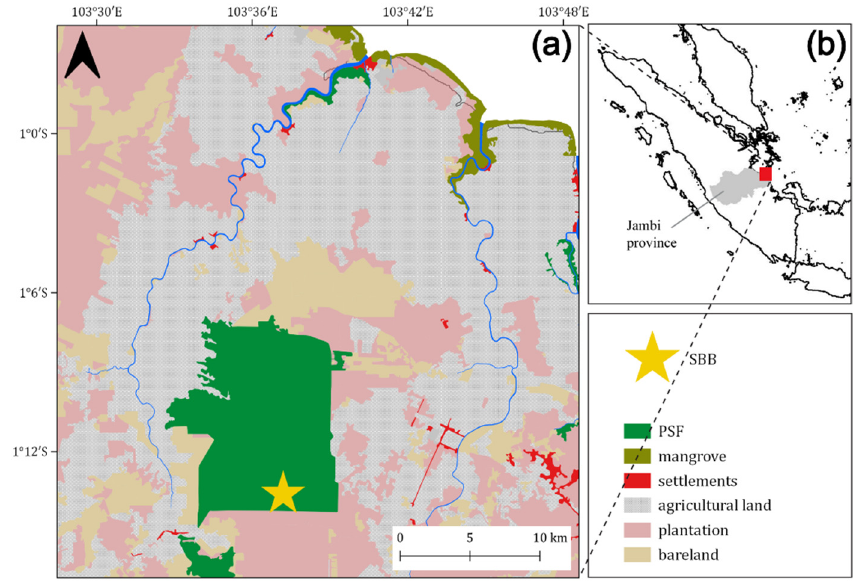
Figure 1. Map of the study region ( a ) and the location of the study site ( b ). SBB—Sungai Buluh peatland, PSF—peat swamp forest.